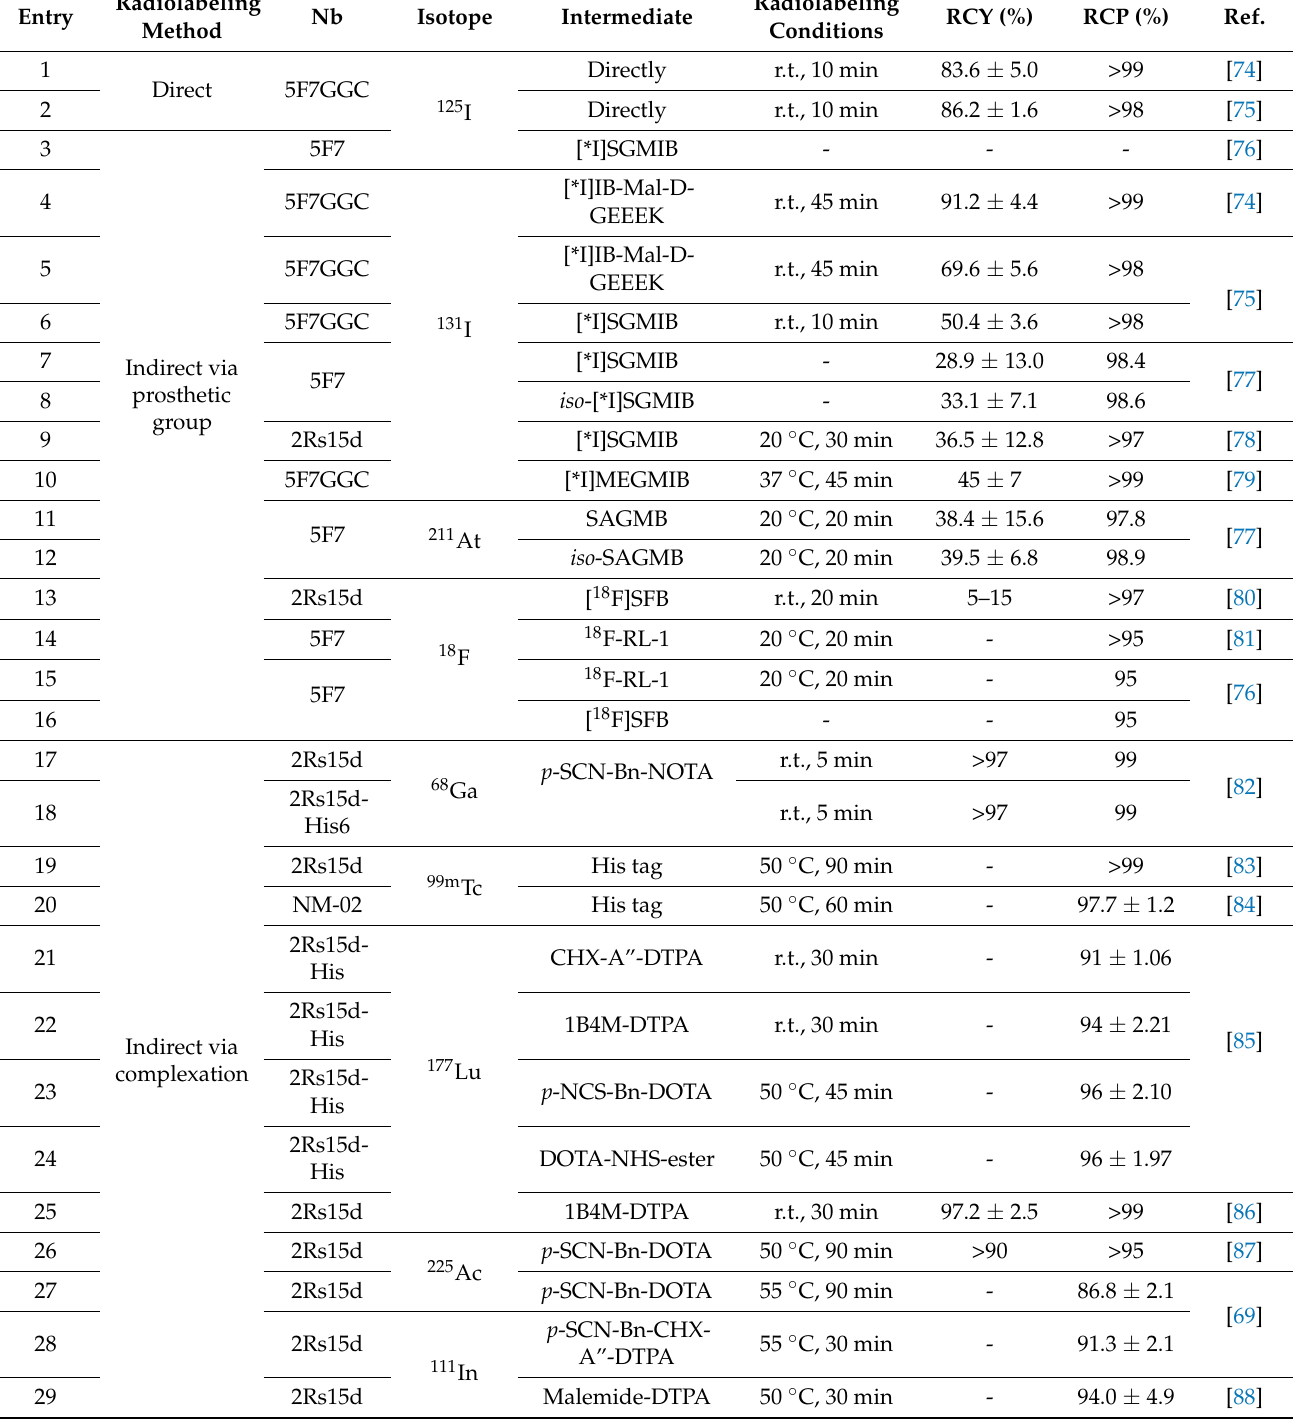
Table 2. A brief overview of the radiolabeling strategies including radioisotope, nanobody, labeling conditions, radiochemi- cal yield and radiochemical